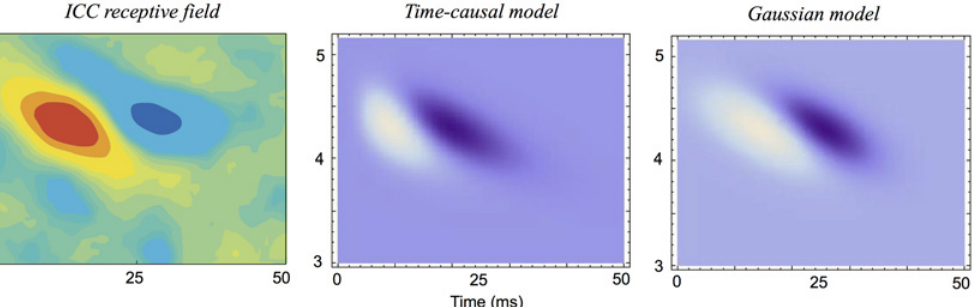
Fig 16. (left) A non-separable spectro-temporal receptive field in the central nucleus of the inferior colliculus (ICC) of cat as reported by Qiu et al. [31] (schematic simplification only, see fig. 3(a) in [31] or fig. 17 in [64] for the original data). (middle and right) First-order temporal derivative of idealized glissando-adapted receptive fields models (90) centered at ν = 4.3 octave, temporal scale σ t = 7 ms, logspectral scale σ ν = 0.20 octave and glissando v = − 0.02 octave/ms for both models and additionally temporal delay δ = 23 ms for the Gaussian model.